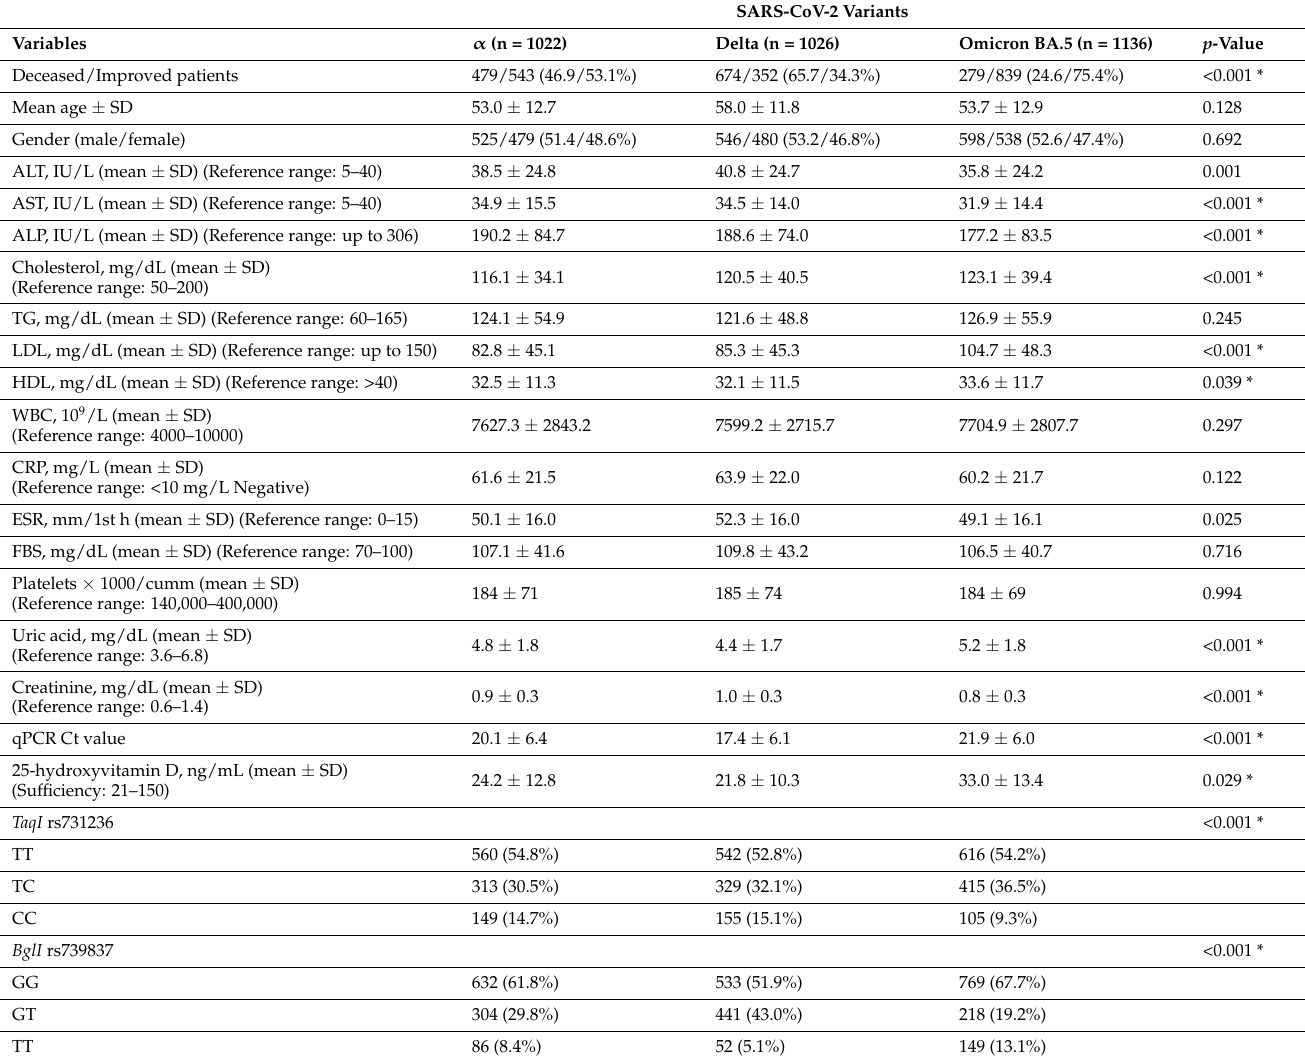
Table 1. Comparison of laboratory parameters between SARS-CoV-2